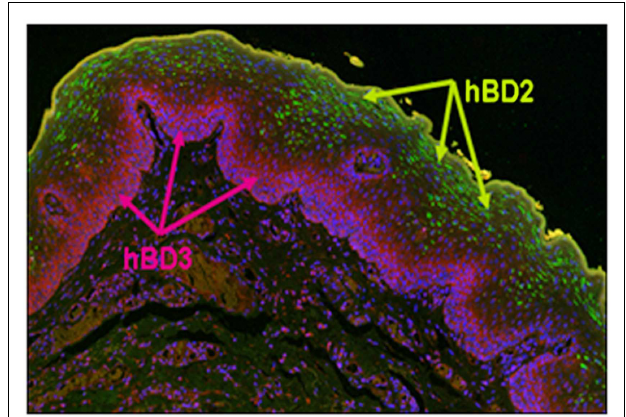
FIGURE 1 | Distribution of hBD-2 and hBD-3 in normal oral epithelium. Formalin fixed and parafilm embedded normal human oral tissue was labeled with an anti-hBD-2 specific primary antibody (Santa Cruz, Santa Cruz, CA, USA), and detected with AlexaFluor 488 (Invitrogen, CA, USA; green) conjugated secondary antibody. hBD-3 was labeled with a rabbit anti-hBD-3 (Novus Biologicals Inc., Littleton, CO, USA), specific primary antibody and detected using an AlexaFluor 594 (purple) conjugated donkey anti-rabbit (Invitrogen). Note green fluorescence detection of hBD-2 localized to the stratum spinosum and stratum granulosum, while pink/red fluorescence detects hBD-3 exclusively to the stratum basale. hBD-1, not shown, is localized to the same regions as